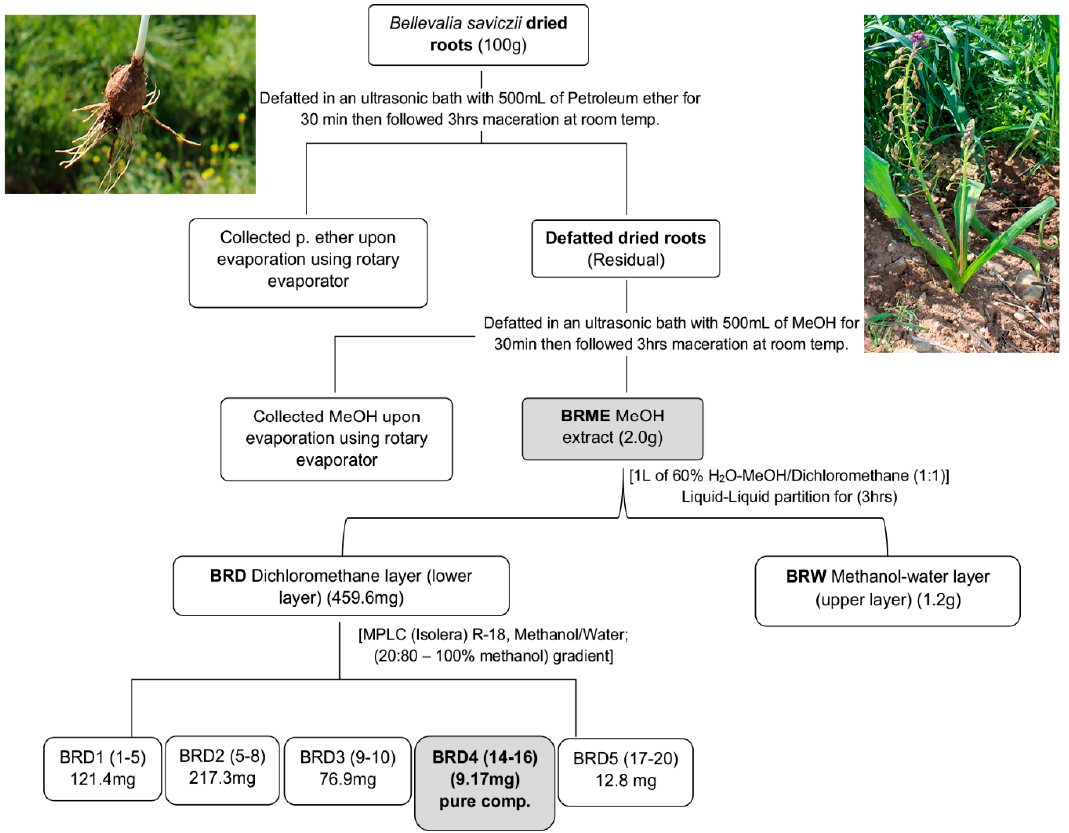
Figure 1. Scheme for extraction and purification of B. saviczii preparation.